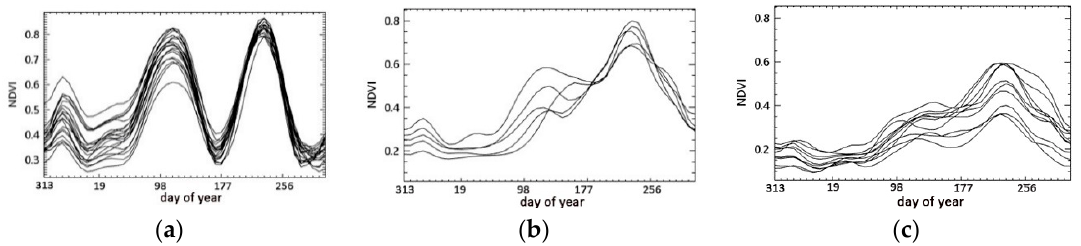
Figure 3. The Normalized Difference Vegetation Index (NDVI) time series curves of sample points ( a ) represents the winter wheat; ( b ) represents the forest; ( c ) represents buildings. Table 4. The accuracy of the extracted area of winter wheat in each city (unit: Hectares). City Extracted Area Area in Statistical Data Accuracy